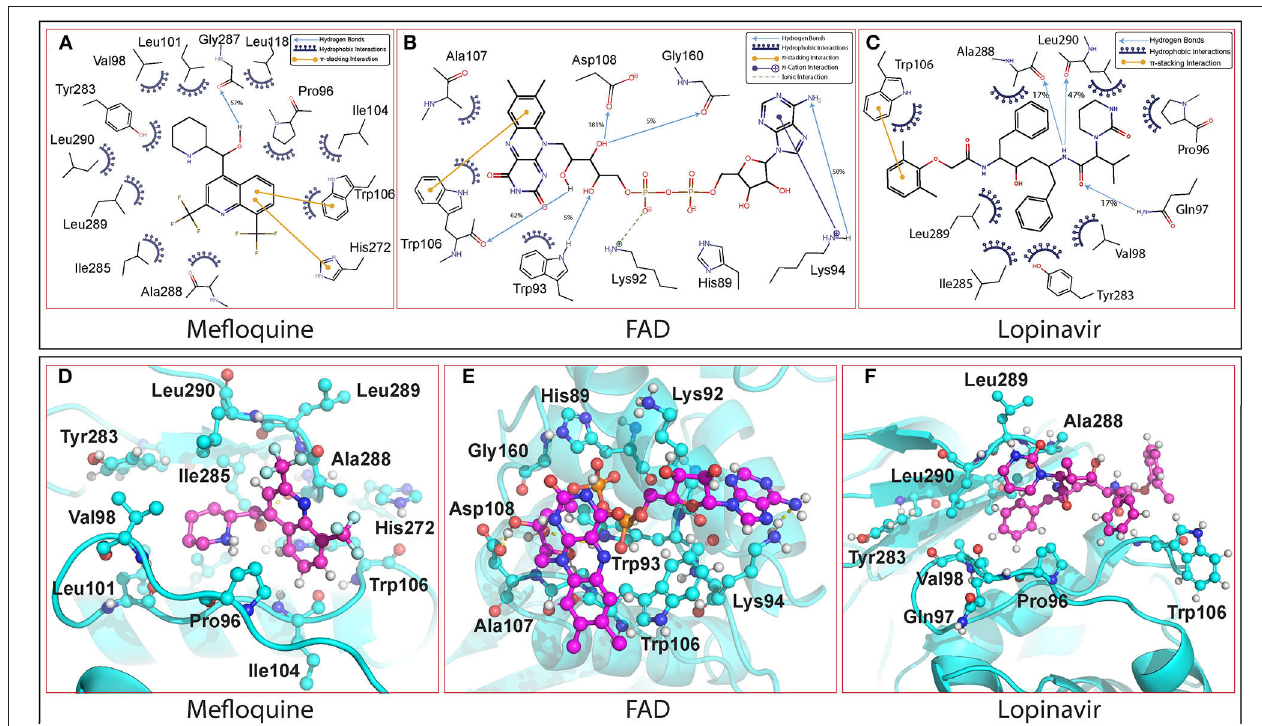
FIGURE 3 | The interactions of the molecules with PLpro observed throughout the 100 ns simulations are depicted. The interactions were estimated by geometric criteria and visual inspection. (I) 2-D Interaction diagram of (A) Mefloquine, (B) FAD, and (C) Lopinavir with PLpro of SARS-CoV-2. (II) 3D-binding pose of (D) Mefloquine, (E) FAD, and (F) Lopinavir with PLpro of